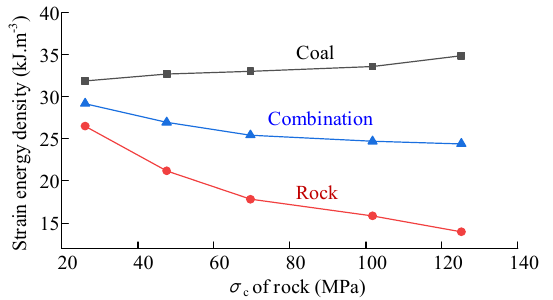
Figure 8. Partition strain energy density curves of different coal–rock combinations.